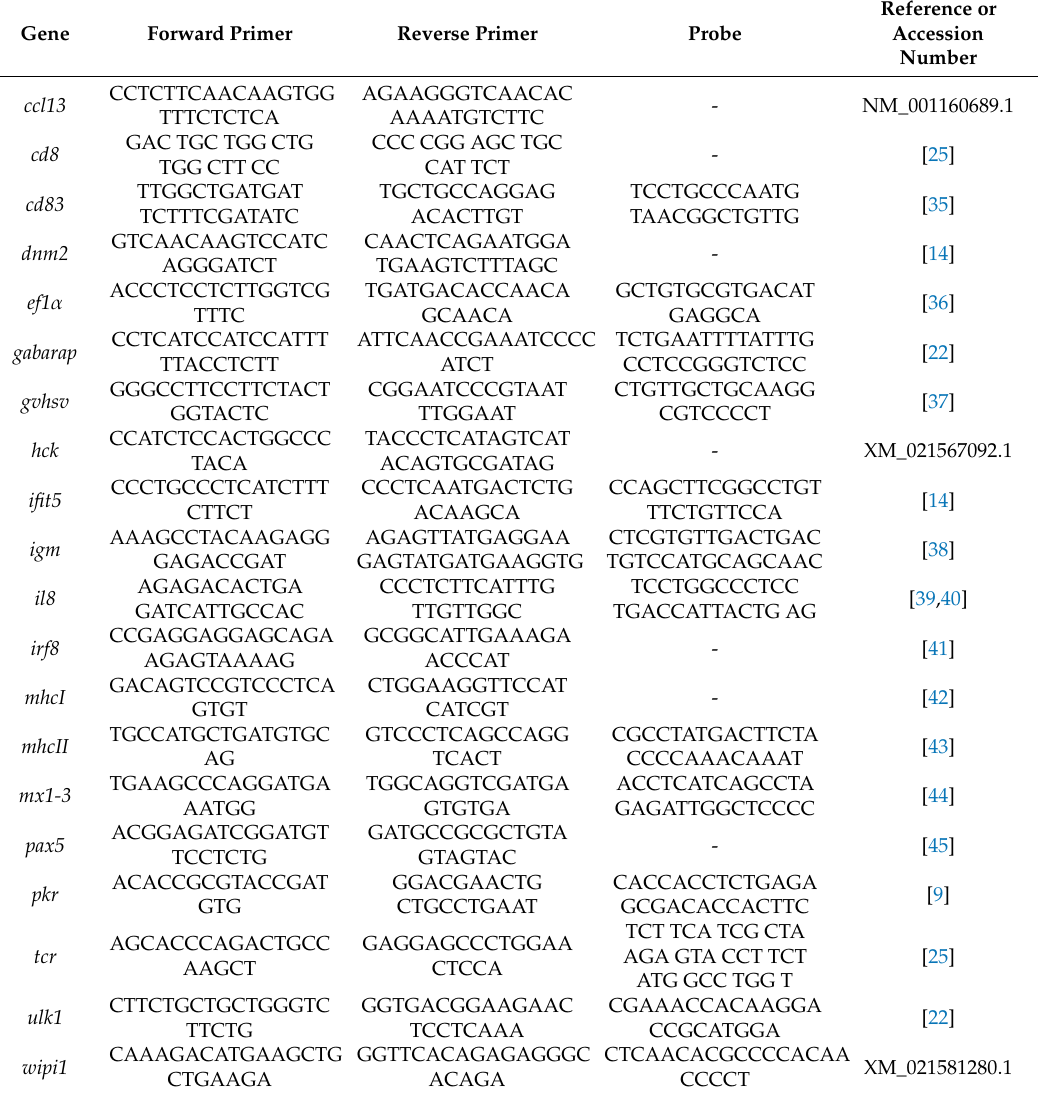
Table 1. The list of primers and probes